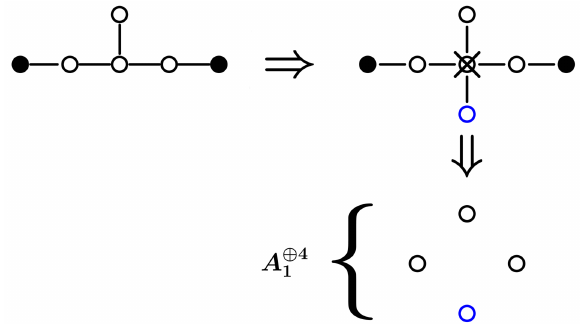
subalgebra in the N = 6 Figure 10 . A ⊕ 4 1